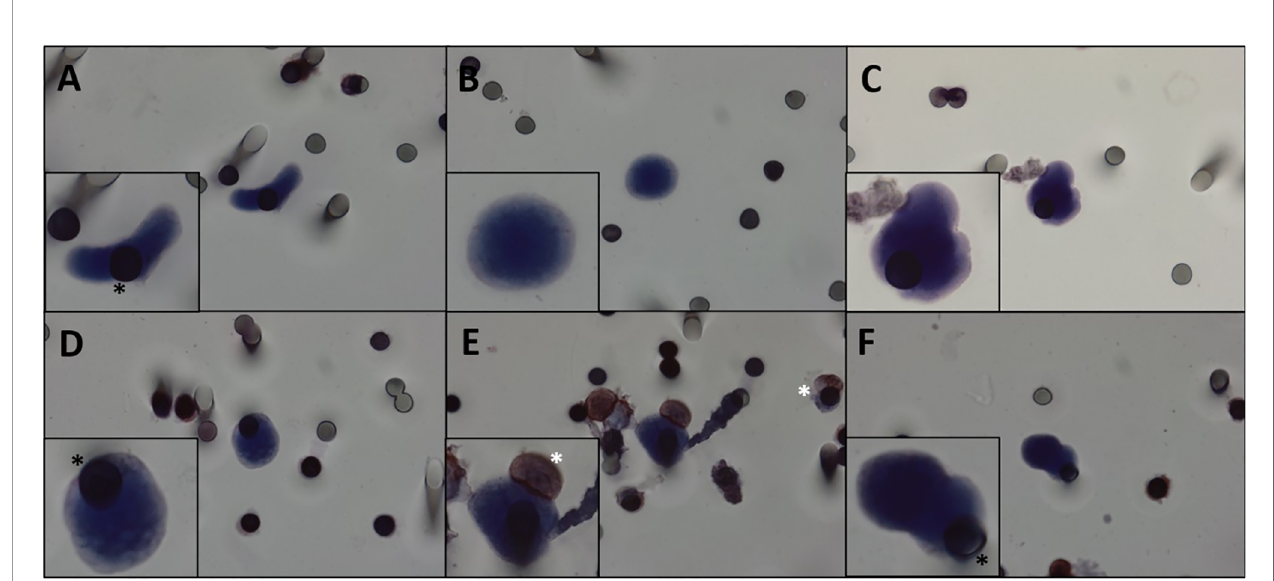
FIGURE 1 | (A – F) CTCs isolated from patients with DTs. Cells visualized with hematoxylin. We can observe pleomorphic desmoid tumor CTCs with all cytopathological features: nucleus size ≥ 12 µm, hyperchromatic and irregular nucleus, visible presence of cytoplasm, and a high nucleus – cytoplasm ratio (31). White asterisk: leukocytes. Black asterisk: membrane spots. Images were taken at ×600 magni fi cation using a light microscope (Research System Microscope BX61 — Olympus, Tokyo, Japan) coupled to a digital camera (SC100 — Olympus, Tokyo, Japan). CTCs, circulating tumor cells; DTs, desmoid